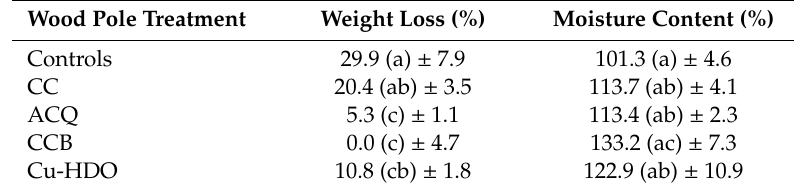
Table 3. Weight losses of treated wood pole segments by brown rot fungi after 24